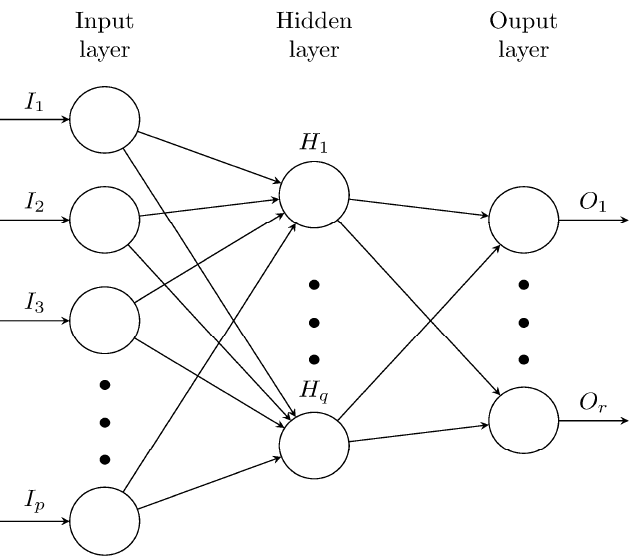
Figure 5. A schematic ANN including input, hidden and output